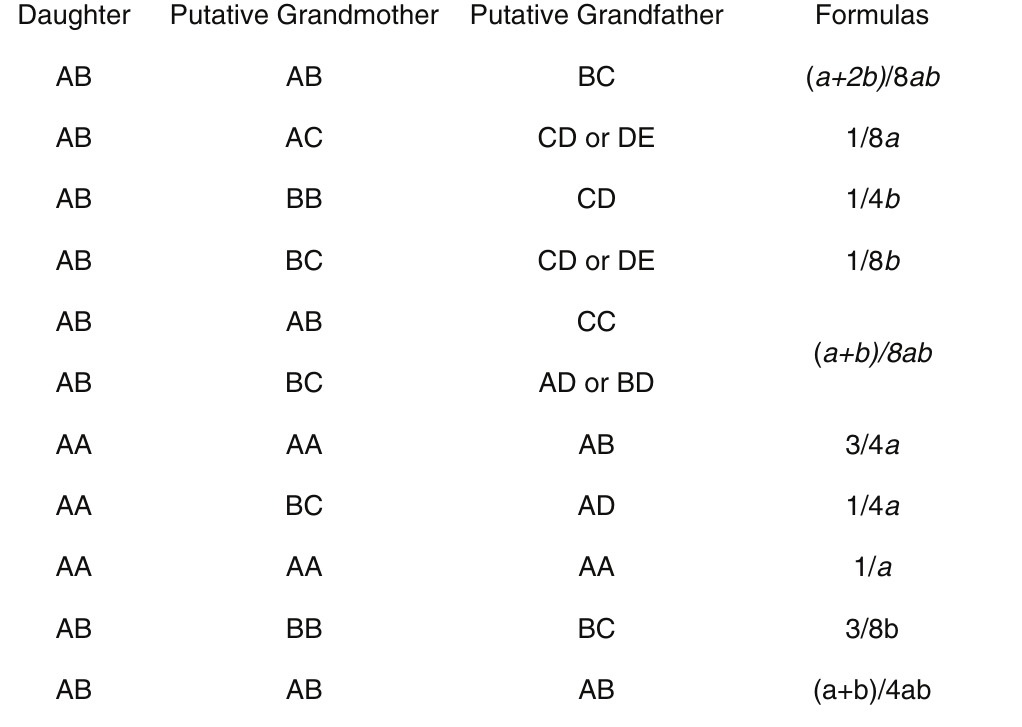
Table S3 - Formulas to calculate PI considering the profile configurations depicted with AS STRs, in case